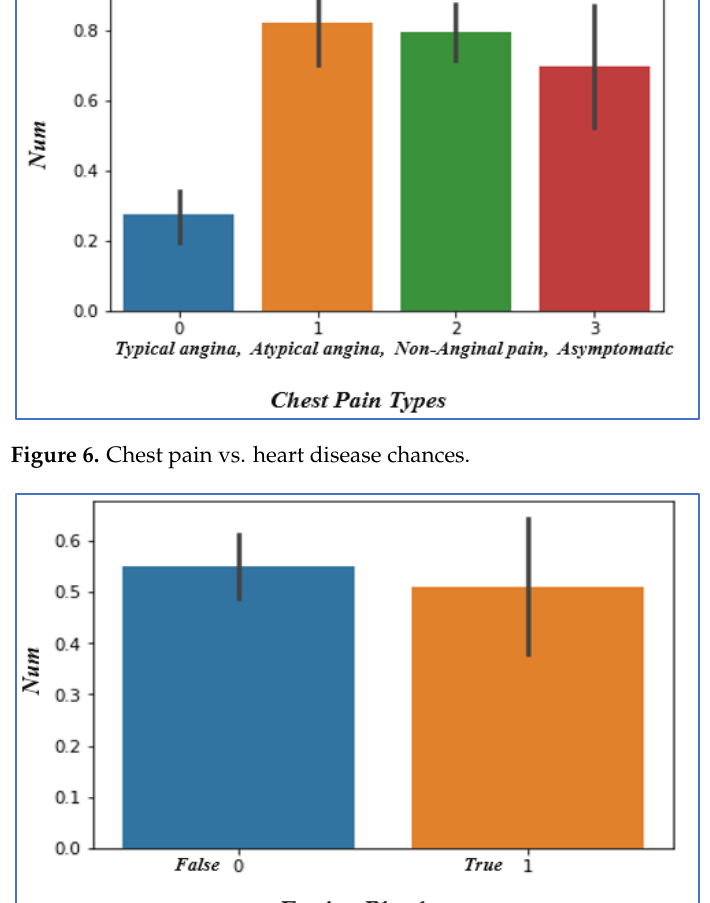
Figure 6. Chest pain vs. heart disease chances.